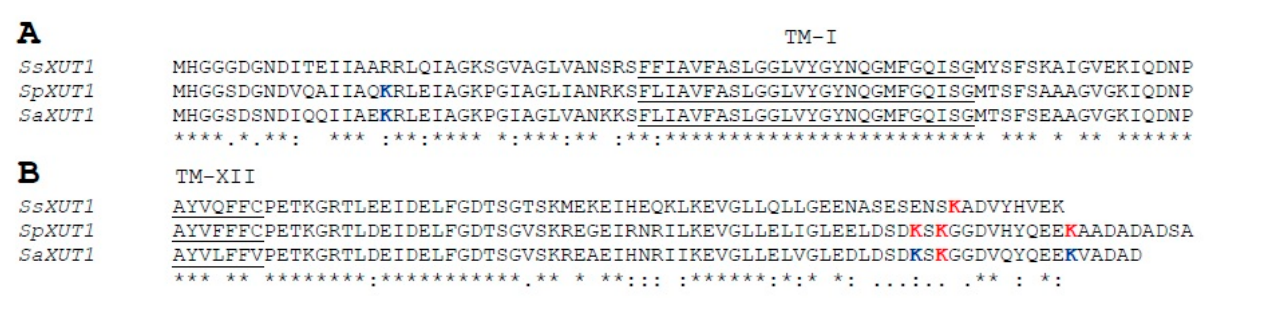
Figure 4. Sequence alignment of the N-terminal ( A ) and C-terminal ( B ) cytoplasmic domains of the SsXUT1, SpXUT1 and SaXUT1 transporters. The protein sequences were aligned using Clustal Omega [55]; the transmembrane α -helices (underlined residues) were predicted with the PRALINE program [56], and the lysine residues with medium (blue) or high (red) ubiquitinylation potential were determined with the UbPred program [58].